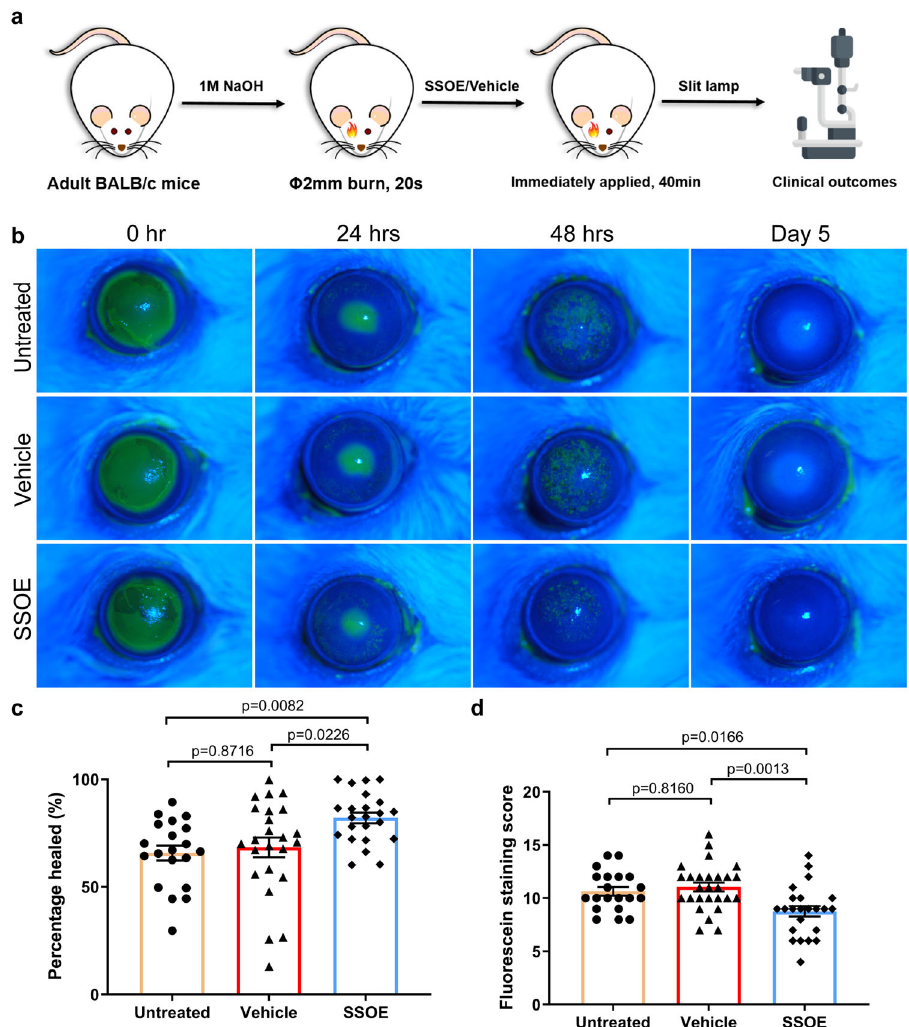
Fig. 3 | SSOE accelerates corneal epithelial wound healing after alkali burn. a Schematicdepictingocularalkaliburninmice:a2-mmcircular fi lterpapersoaked with 1M sodium hydroxide (NaOH) was applied to the center of the right eye for 20s, followed by copious irrigation till the pH level returned to normal. SSOE or unoxygenatedvehiclecontrolwerethenimmediatelyappliedtotheeyefor40min. b Fluorescein staining (green color when photographed with Cobalt blue fi lter) highlightscornealepithelialdefectsat24handsuper fi cialpunctatekeratitisat48h